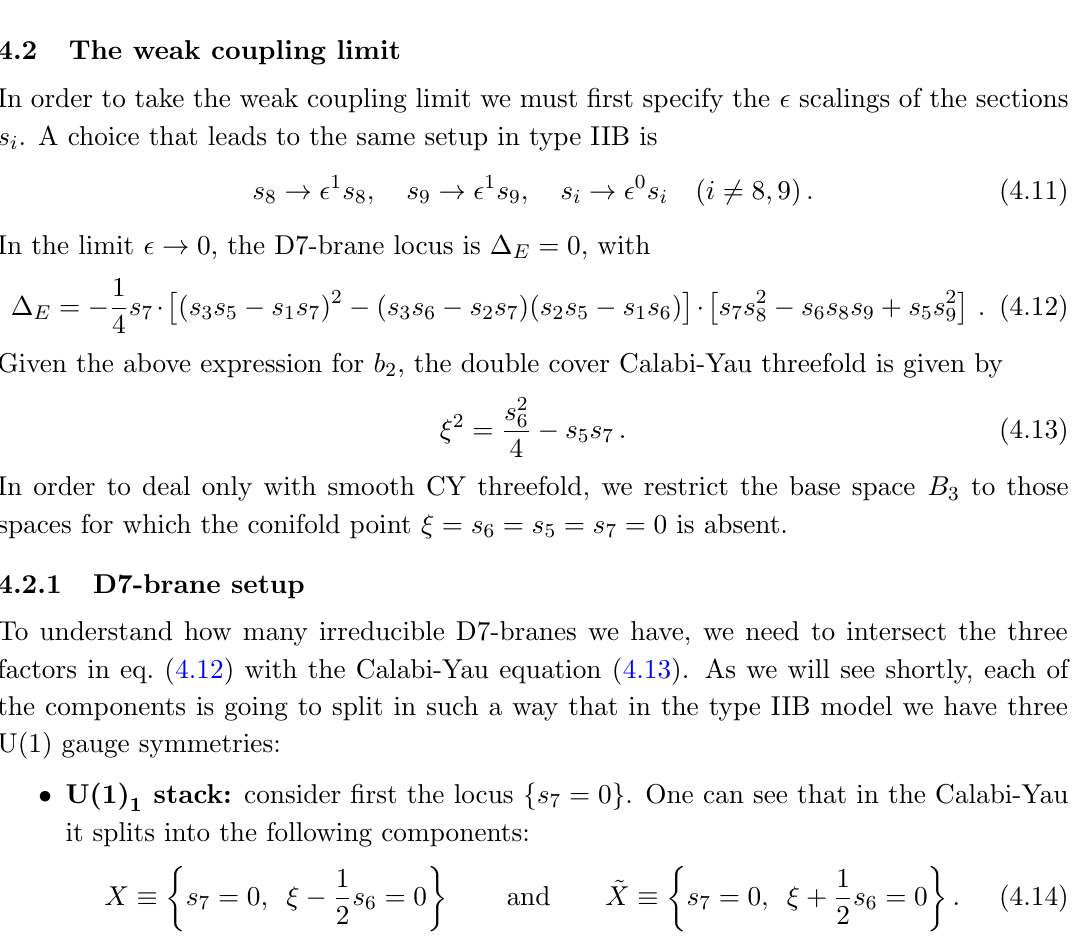
Table 10 . Charged matter representations under U(1) 2 and corresponding codimension-two (cid:12)bers of X F 5